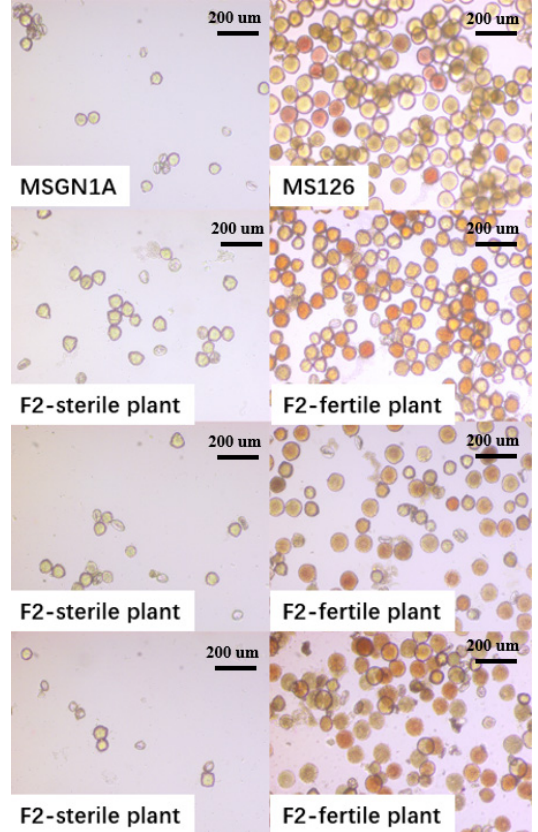
Figure 1. Microscope detection of pollen in alfalfa. MSGN1A is the pollen of alfalfa cytoplasmic male sterility plants, and MS126 is the pollen of recovery line plants corresponding to alfalfa cytoplasmic male sterility lines; below is the male sterility plant in the alfalfa F2 segregation population and pollen of fertile plants in the alfalfa F2 segregation population. Table 1. Summary of sequencing data of BSA-seq.